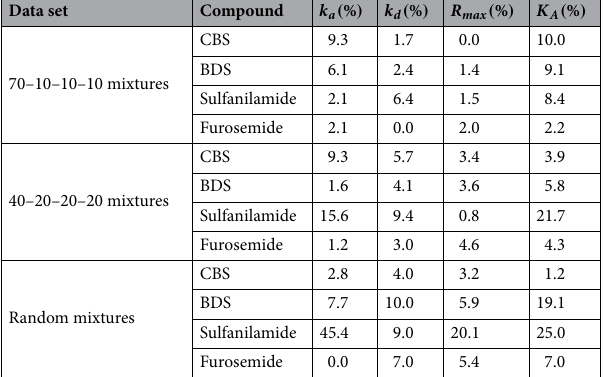
Table 3. Deviation between the parameters identified from single-analyte experiments and parameters identified by fitting the multi-analyte model independently to the 3 data sets (70–10–10–10, 40–20–20–20 and random